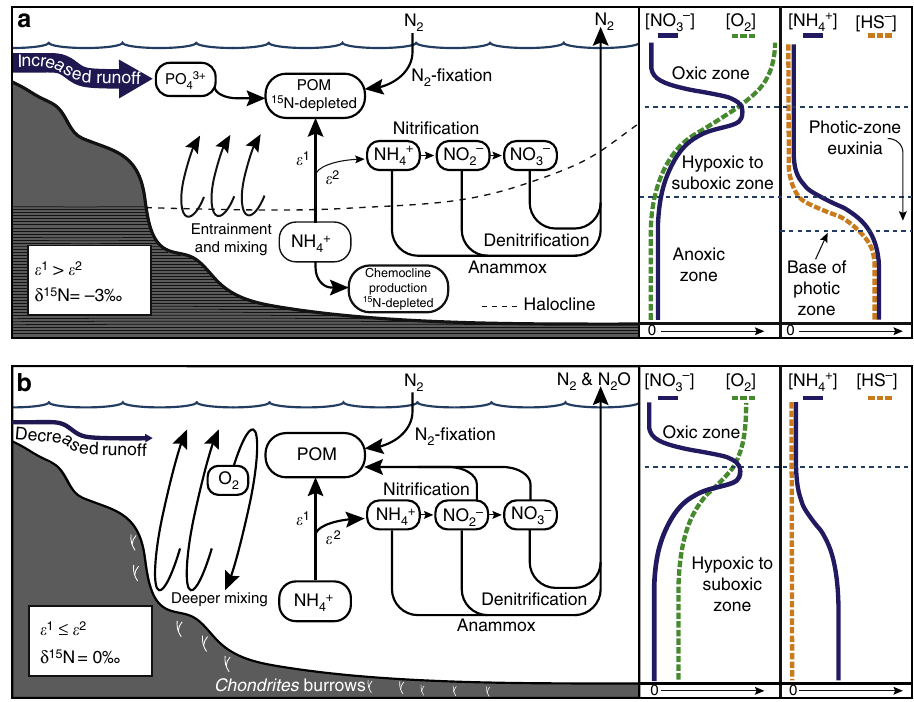
Fig. 4 Schematic diagram of the nitrogen cycle during the PETM at Kheu River. a The nitrogen cycle during the initial and late stages of the PETM when the water column was predominantly anoxic. Nitrogen isotope depletion was driven by mixing and entrainment of ammonium from below the chemocline into the lower photic zone. In this situation, high ammonium concentrations allowed for the expression of an uptake fractionation ( ε 1 ) by primary producers 41 . Less ef fi cient utilization ( ε 2 ) of ammonia by nitrifying archaea and bacteria, and its subsequent reduction to N 2 via denitri fi cation and anammox serve as a sink for residual 15 N-enriched ammonium. b During the middle interval of the PETM at Kheu River, deeper mixing allowed for invasion of O 2 to the benthic boundary layer, development of suboxic/hypoxic conditions that may have allowed for the production of N 2 O and relative 15